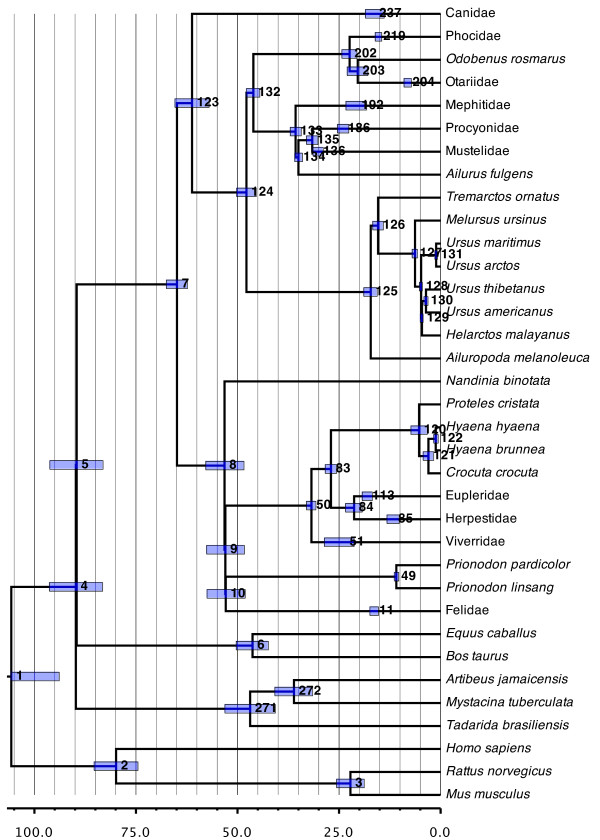
Phylogenetic relationships and divergence-time estimates among the major carnivore lineages and within the smaller families. Nodes are individually numbered, with node bars indicating 95% confidence intervals on the divergence time estimates (in Ma before present).